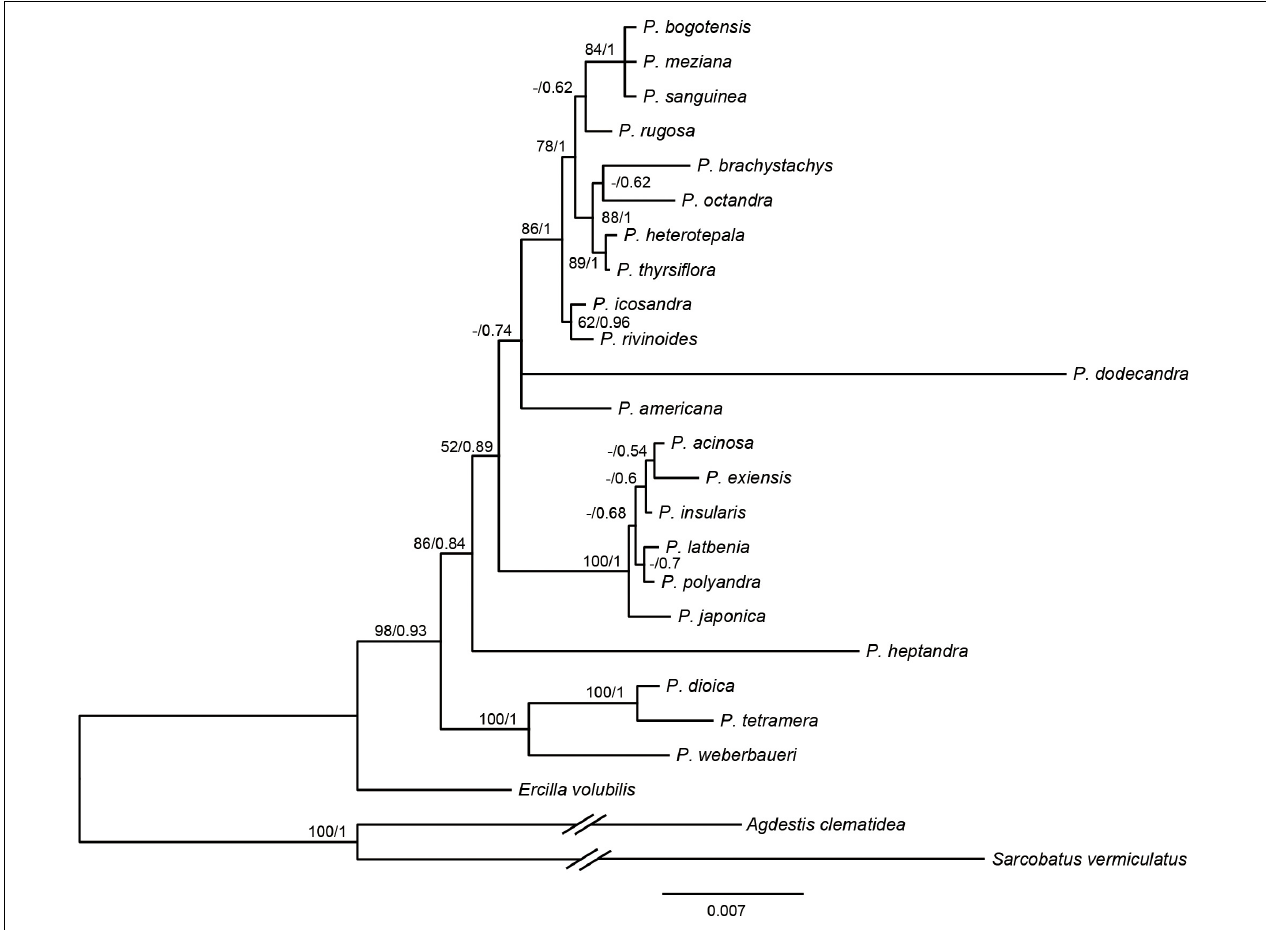
FIGURE 2 | Phylogenetic trees of Phytolacca based on the 3g22s dataset. ML bootstrap support values/Bayesian posterior probabilities were presented at each node.